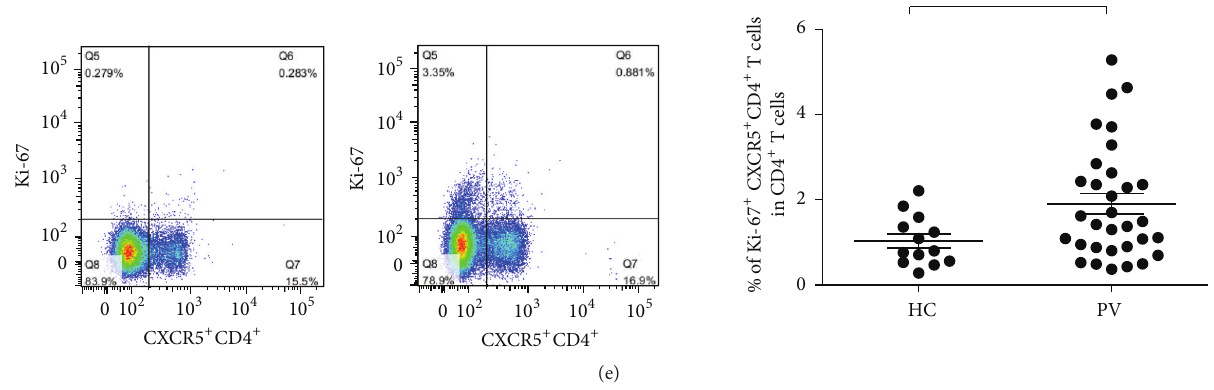
Figure 1: Increased frequency of circulating CXCR5 + CD4 + Tfh (cTfh) cells in patients with psoriasis vulgaris. (a) Comparison of the percentages of cTfh cells in patients with psoriasis vulgaris (PV) and healthy controls (HC). The cTfh cell frequency in patients with psoriasis vulgaris is significantly higher than in healthy controls. (b) ICOS expression on cTfh cells in patients with psoriasis vulgaris and healthy controls. Compared with healthy controls, ICOS expression on cTfh cells is significantly increased and has a positive correlation with the frequency of cTfh cells in psoriasis patients. (c) The levels of PD-1 on cTfh cells in patients with psoriasis vulgaris and healthy controls. The frequency of PD- 1 high CXCR5 + CD4 + /CD4 + T cells is statistically increased and associated with cTfh cell frequency in psoriasis patients. Each dot represents one participant. 𝑃 values are shown. (d) The expression of HLA-DR on cTfh cells in patients with psoriasis vulgaris and healthy controls. The expression of HLA-DR on cTfh cells was significantly higher in psoriasis patients than in healthy controls. (e) Ki-67 expression on cTfh cells in patients with psoriasis vulgaris and healthy controls. Compared with healthy controls, there was a higher level of Ki-67 expression on cTfh cells in psoriasis